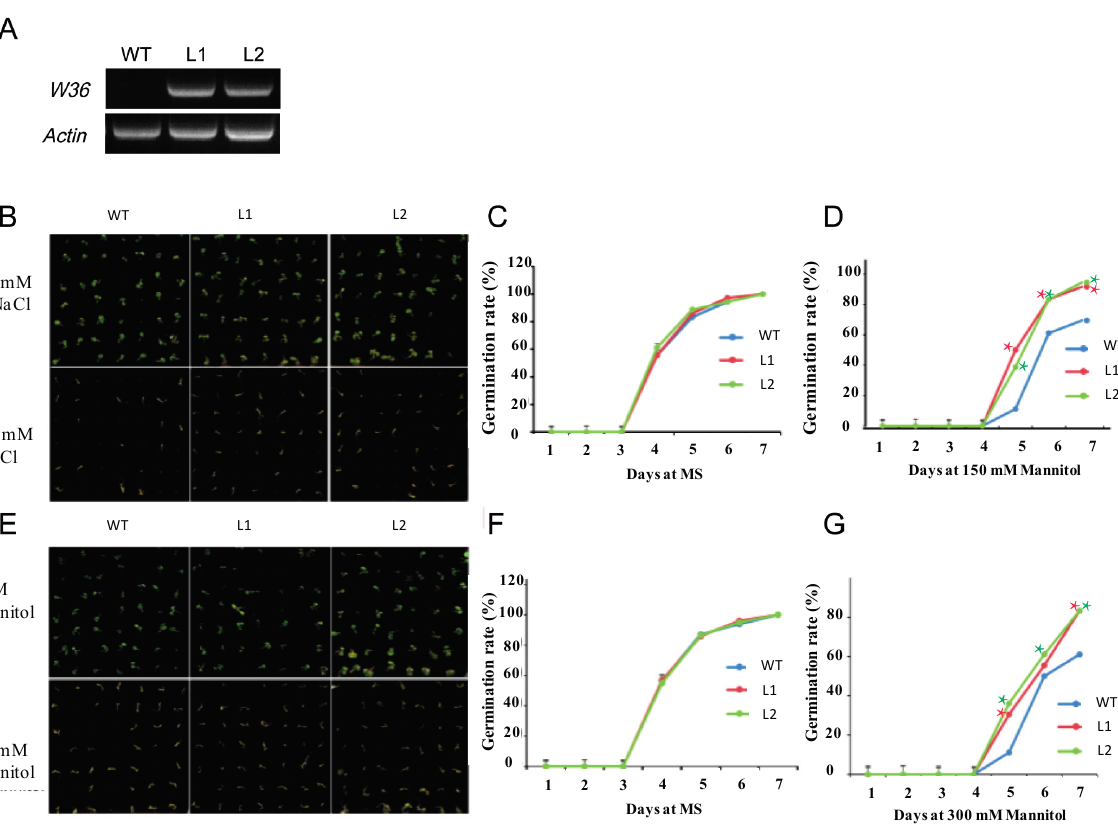
Figure 5. Germination of wld-type and transgenic Arabidopsis lines under salt and mannitol treatment. All seeds were vernalized at 4 °C for 72 h. ( A ) Expression of W36 in transgenic lines by semi-quantitative RT-PCR. The Actin gene was used as a reference; ( B , E ) showed the seeds germination of wild-type and transgenic Arabidopsis lines; ( C , D , F , G ) showed the tendency of changing on seeds germination. Data are means ± SD of three independent experiments. Asterisks indicate significant differences ( * p < 0.05; Student’s t